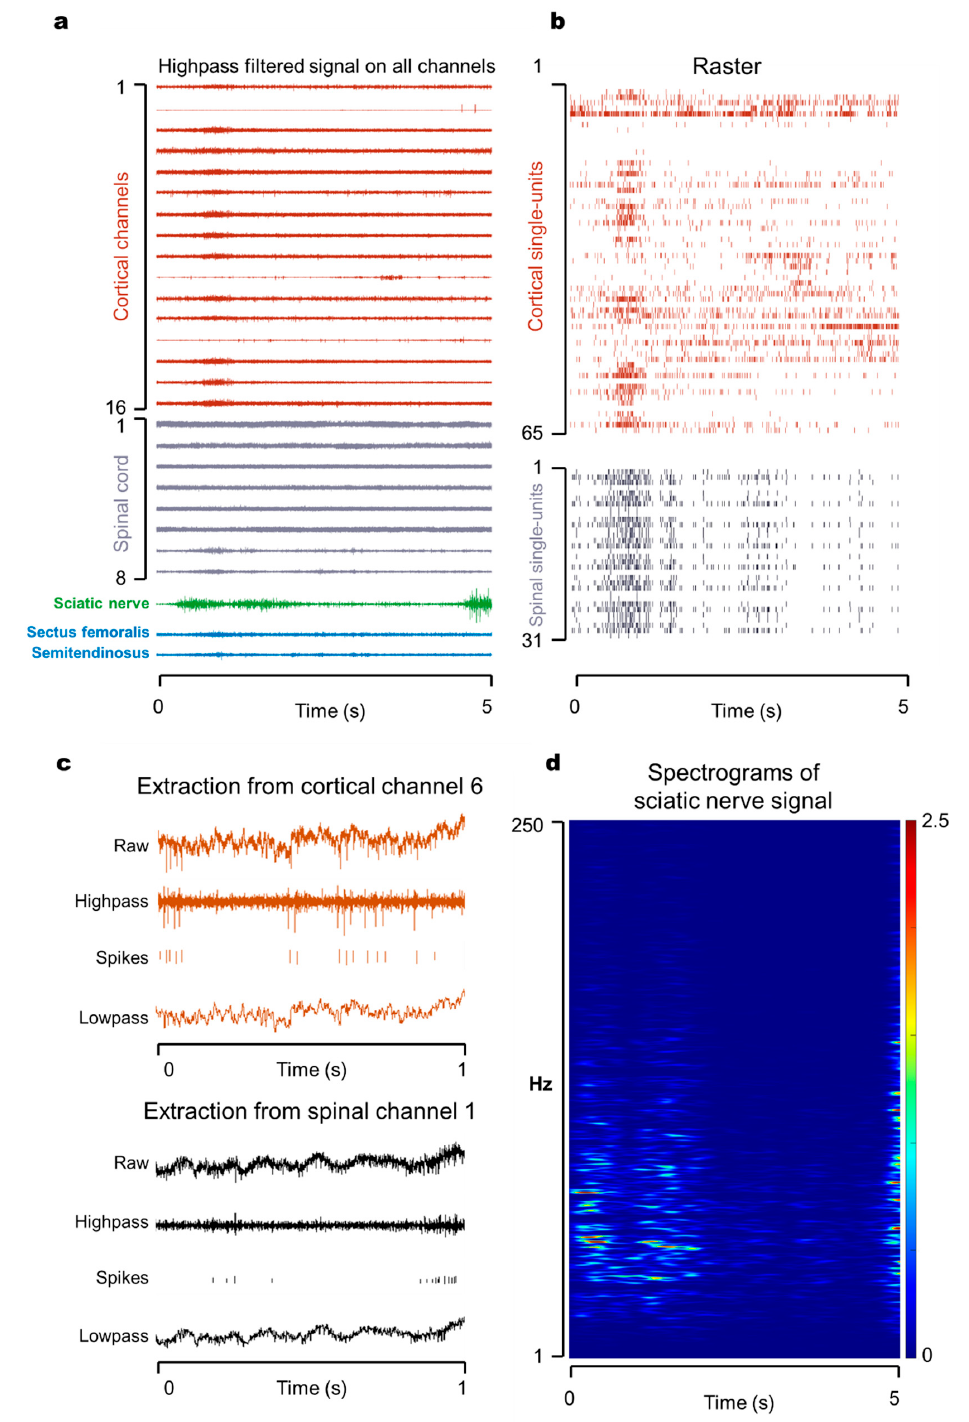
Figure 3. Electrophysiological data from freely moving rodents. Demonstration of wide-band (1–4 kHz) recording of neural and muscular data using wired and wireless sensors from which more information can be further extracted. ( a ) Graph of multisite simultaneous neural recording of motor pathway over a 5-second duration. Cortical channels in red; spinal cord channels in grey; sciatic nerve signal in green; EMGs in light blue. ( b ) Plot of raster of single unit of cortical and spinal cord data over the same time duration. ( c ) Example of information extraction on a single channel (channel 6 for cortical signal and channel 1 for spinal cord signal) over a 1-second time window. High pass and low pass was divided from 350 Hz. Waveforms larger than 3.5 × standard deviation were isolated as spikes. ( d ) Spectrograms of sciatic nerve signal ranging from 1 to 250 Hz over the same 5